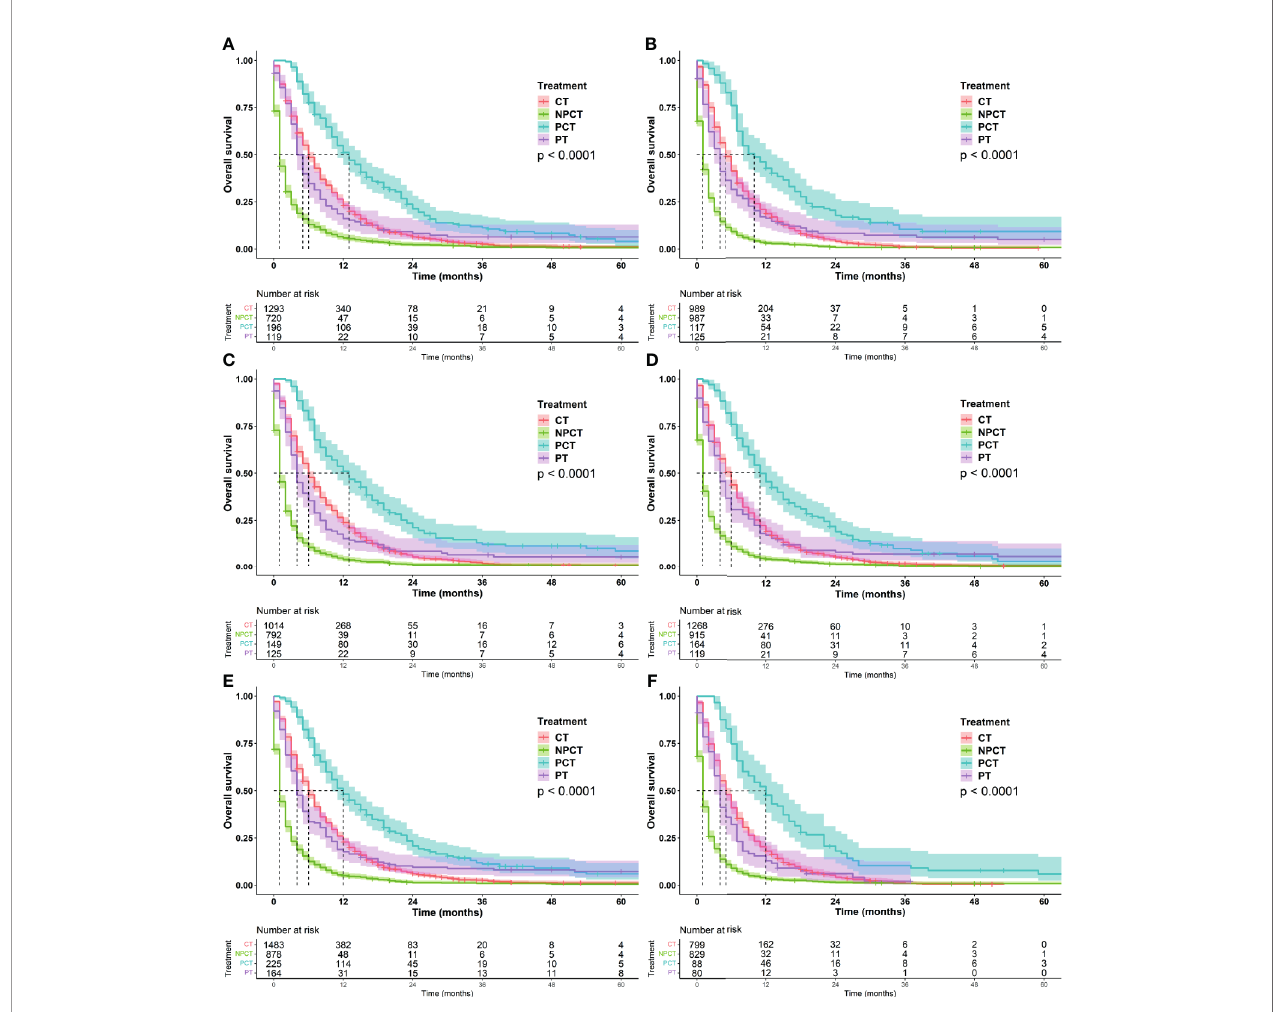
FIGURE 3 | Kaplan-Meier survival curves for subgroup analysis of patients with metastatic pancreatic cancer with different clinical characteristics. (A) : age ≤ 66 years, (B) : age>66 years, (C) : female, (D) : male, (E) : married, (F) :